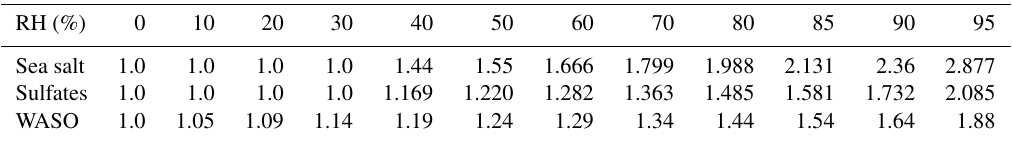
Table A2. Growth factors used to characterise the size distributions of sea salt, sulfates and organic matter. RH